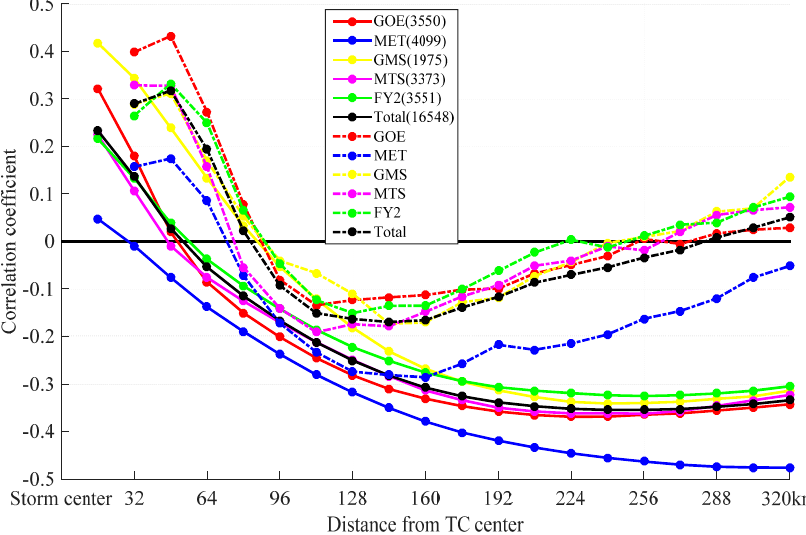
Figure 2. Scatter diagram of the correlation coefficient between the size of TCs and the brightness temperature factor obtained using data from different satellites. The solid lines represent the brightness temperature obtained from different satellites and the dotted lines represent the difference in brightness temperature between neighboring belts. The number of samples is given in parentheses in the legend. For the GOE satellite all variables are significant above 0.90, except TD16, TD17, TD18, and TD19; for the MET satellite all variables are significant above 0.90, except T2; for the GMS satellite all variables are significant above 0.90, except T5, TD15, TD16, and TD17; for the MTS satellite all variables are significant above 0.90, except T3, TD15, TD16, and TD17; for the FY2 satellite all variables are significant above 0.90, except TD13, TD14, TD15, and TD16.